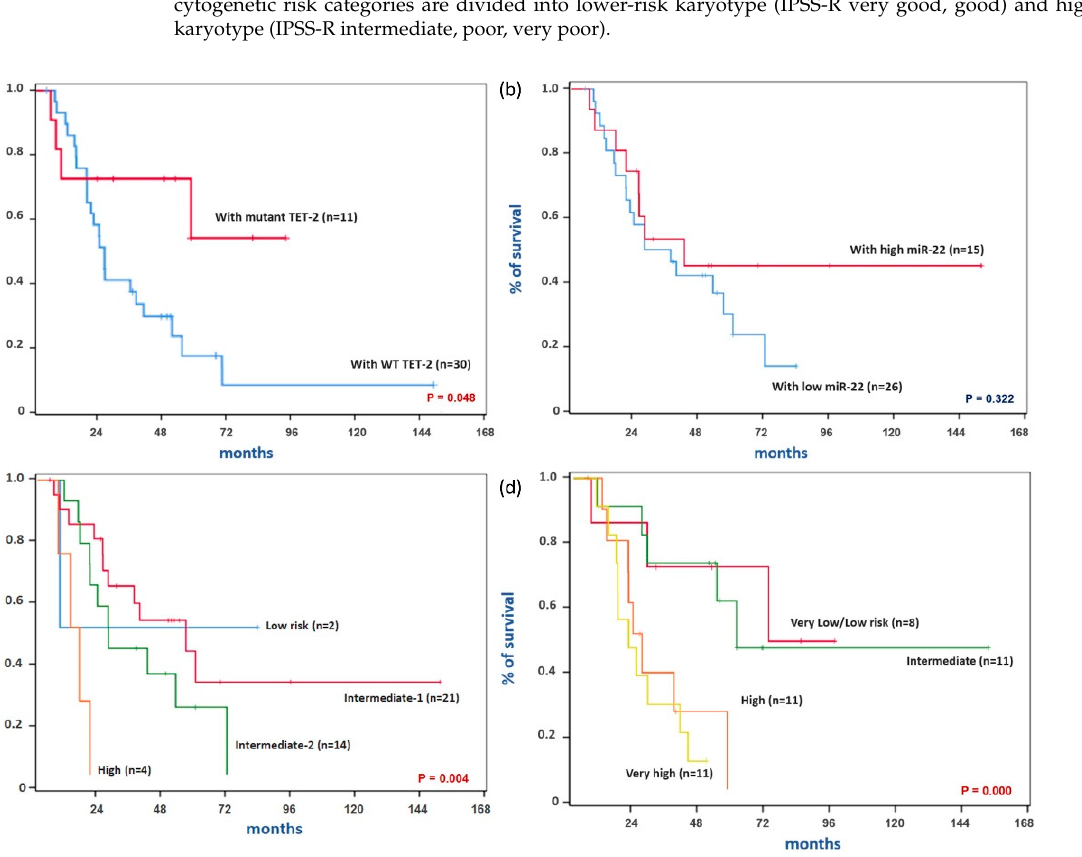
Figure 2. Kaplan–Meier survival curves according to various clinical factors. ( a ) Survival curves according to TET2 mutation status . ( b ) Survival curves according to miR-22 expression status. ( c ) Survival curves according to IPSS risk categories. ( d ) Survival curves according to IPSS-R risk categories . Abbreviations: TET2, Tet methylcytosine dioxygenase 2; IPSS, International Prognostic Scoring System; IPSS-R, Revised International Prognostic Scoring System. p -values were calculated using a log-rank test.